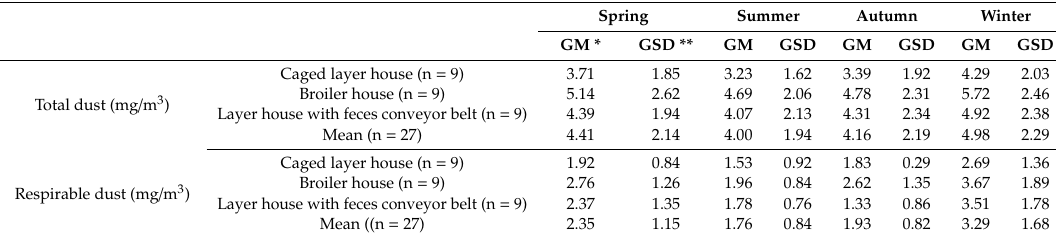
Table 2. Seasonal levels of total and respirable dust in poultry houses.